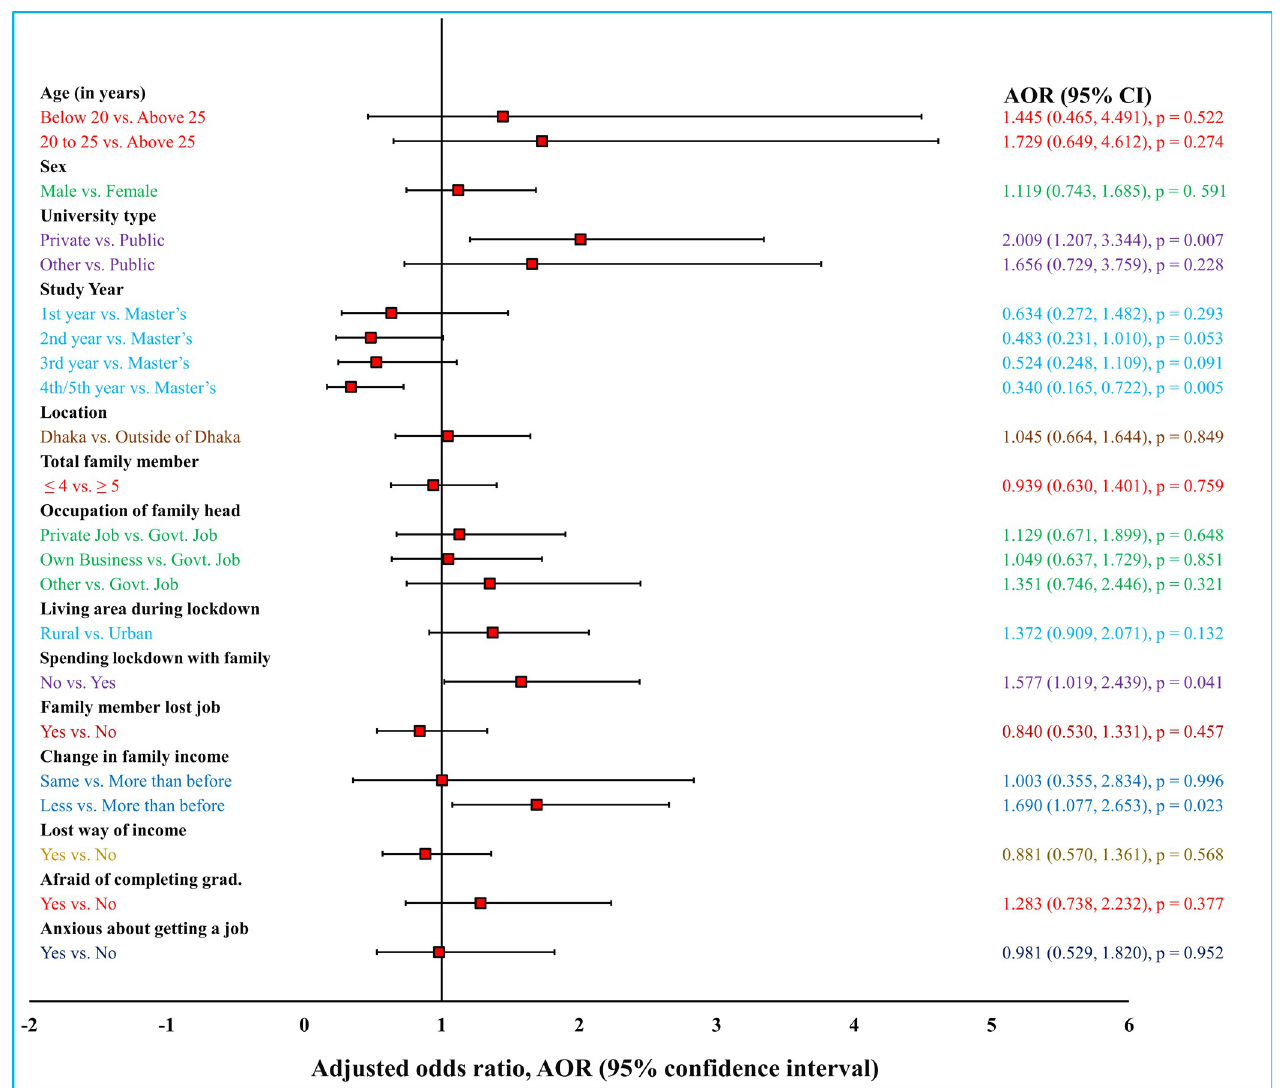
Fig 1. Forest plot representation for multivariate logistic regression analysis of depression among the Bangladeshi university students amid the second wave of the COVID-19